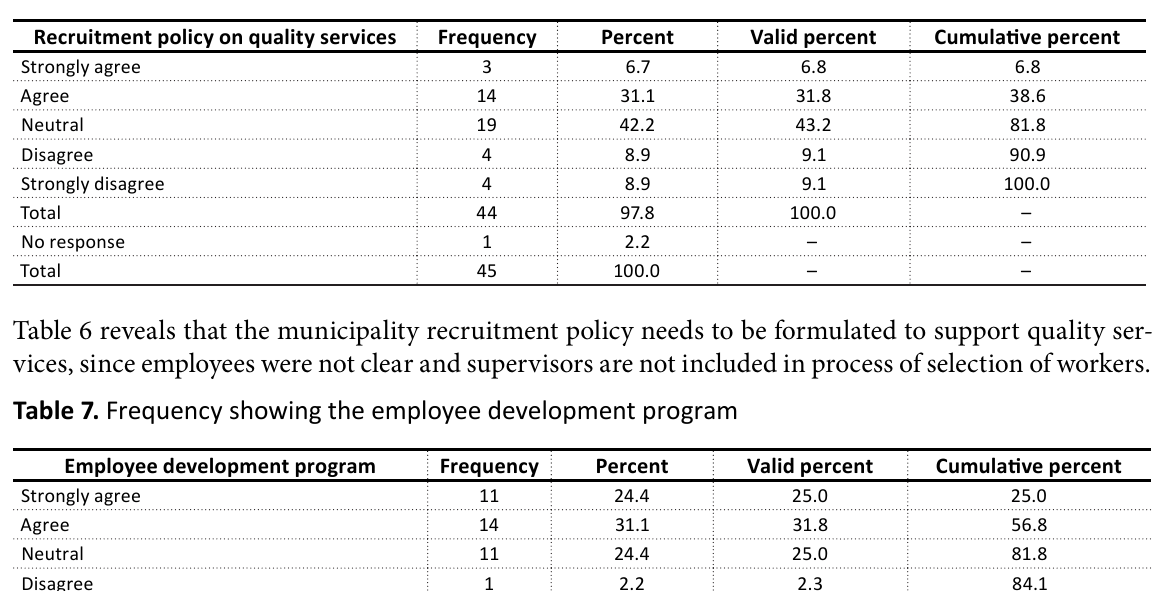
Table 6. Frequency showing the recruitment policy on quality services